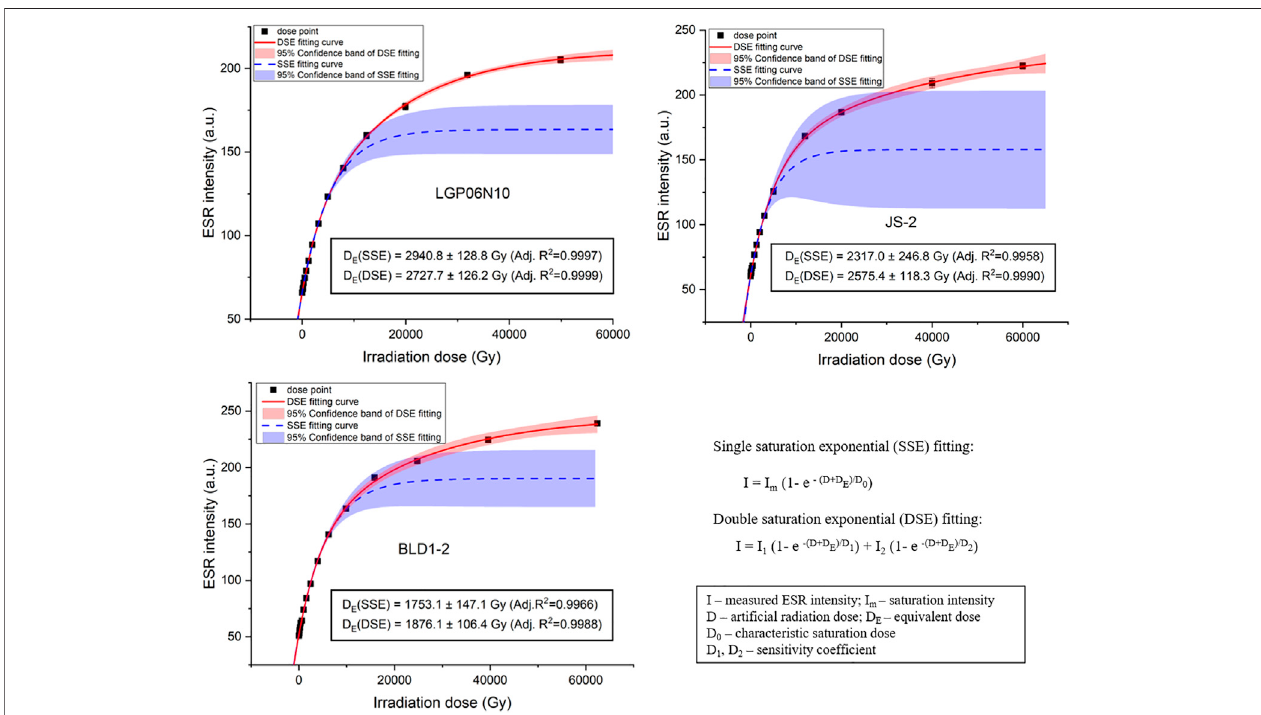
FIGURE 4 | Equivalent dose (D E ) of fossil samples from Three Gorges sites (LGP06N10 from the Longgupo site, JS-2 from Jianshi site, and BLD1-2 from Bailongdong site) determined by single saturation exponential (SSE) function (blue-dashed line and con fi dence band) with 10 dose points up to 5 kGy and double saturation exponential (DSE) function (red solid line and con fi dence band) with 15 dose points up to 60 kGy.